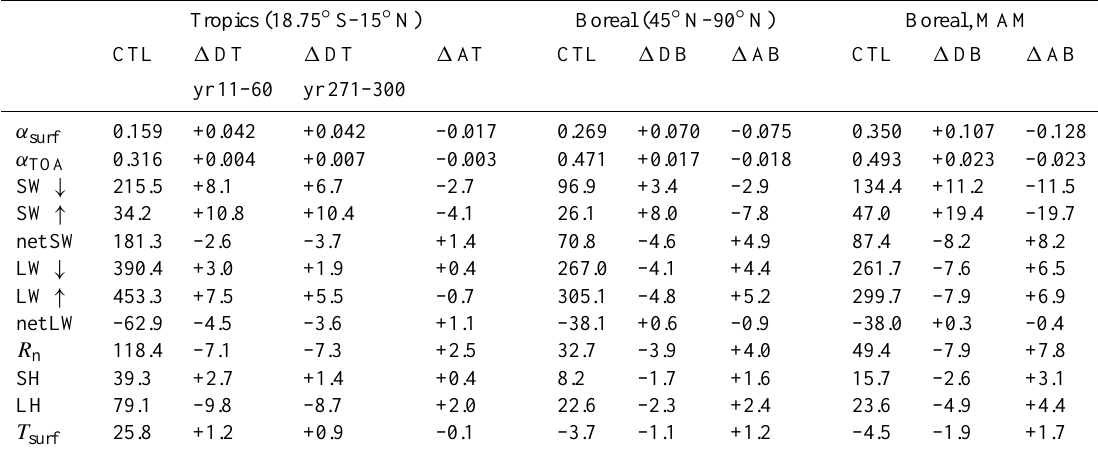
Table 3. The surface energy balance averaged over tropical and boreal land cells. Values for the experiments are given as deviations from the control climate. All fluxes are in W/m 2 , surface temperature in ◦ C. For DT, the time periods 11–60 and 271–300 have been considered separately, all other runs are averaged over the years 11–300. α surf =surface albedo, α TOA =planetary albedo, SW=short-wave, LW=long-